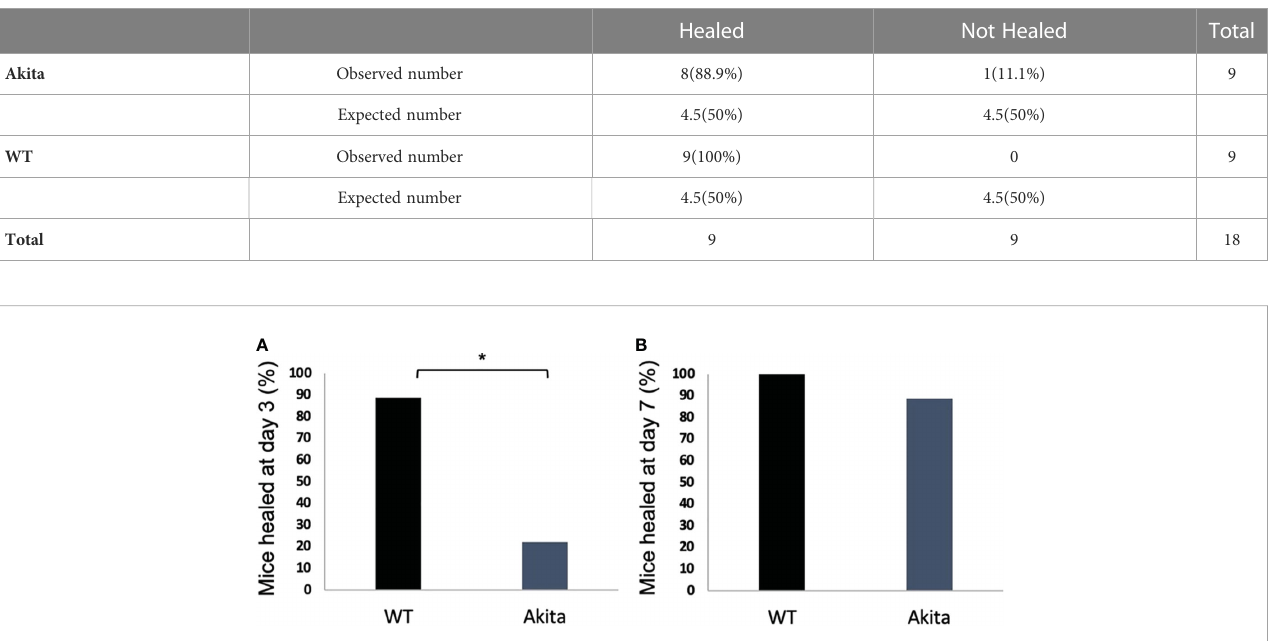
FIGURE 3 Percentage of diabetic and WT mice healed at day 3 after the corneal alkaline injury. (A) Pearson chi-squared test was performed (con fi dence level = 95% and p =0.0044, n = 9 ) and indicated that a signi fi cantly greater percentage of WT mice were healed than diabetic mice at day 3. (B) Pearson chi- squared test was performed and indicated no signi fi cant difference between the percentage of WT mice and diabetic mice healed at day 7 (p > 0.9999, n = 9 for both the WT and Akita groups). *p<0.05.